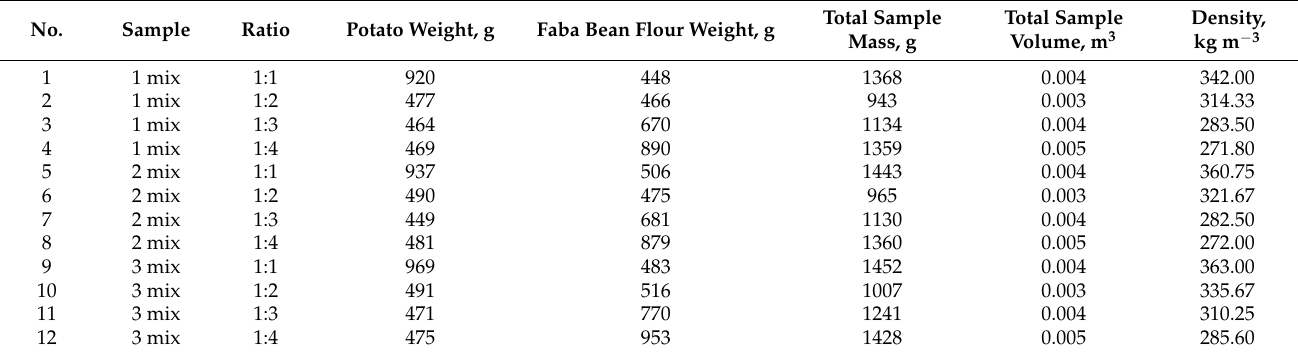
Table 2. Flour ratio and density of faba bean and potato waste